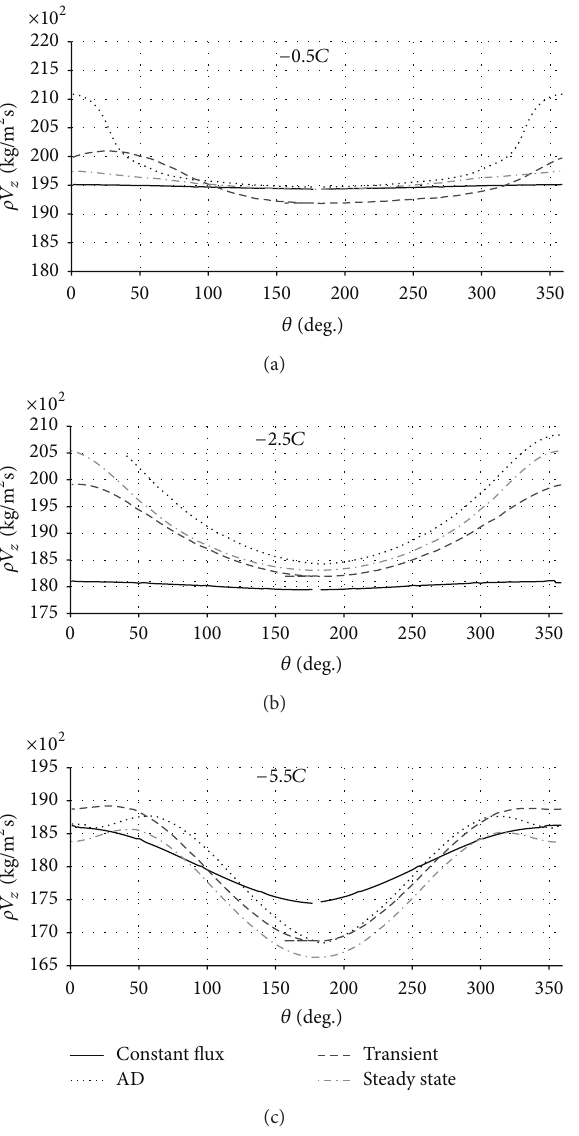
Figure 23: Static pressure